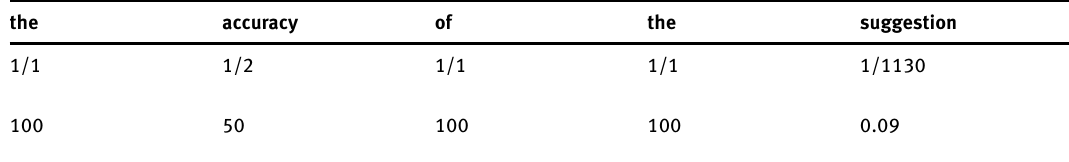
Figure 4: Chart showing the percentage that each lexical item fills the frame in ACL (based on Biber